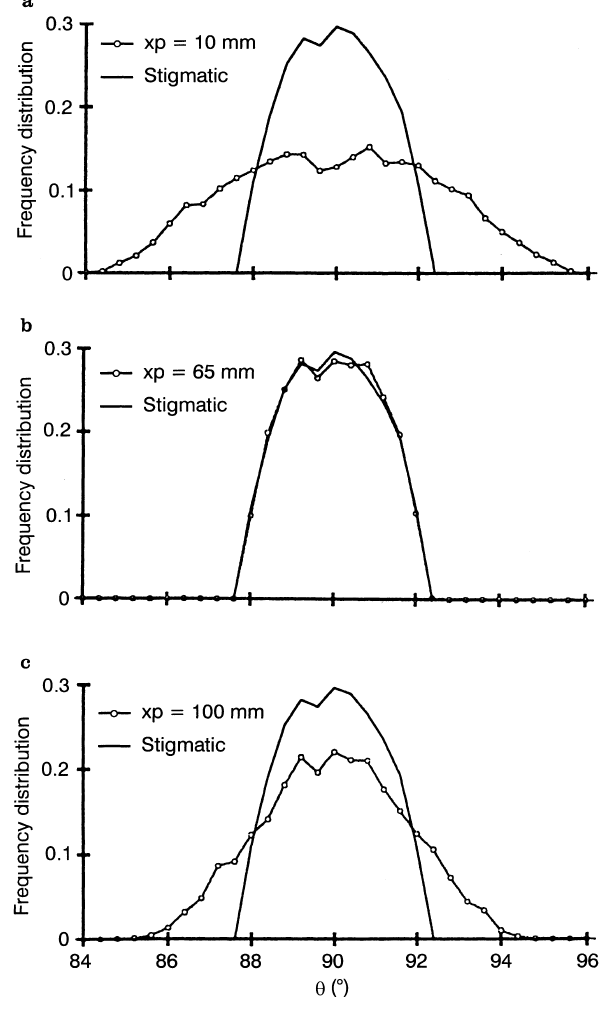
Fig. 7a–c. Statistical distribution ( dotted curves ) of the polar scatter- ing angle for three values of the distance x p (see Fig. 1) between the focal plane of the mirror and the plane defined by the detector array. The solid curve corresponds to a perfectly stigmatic system